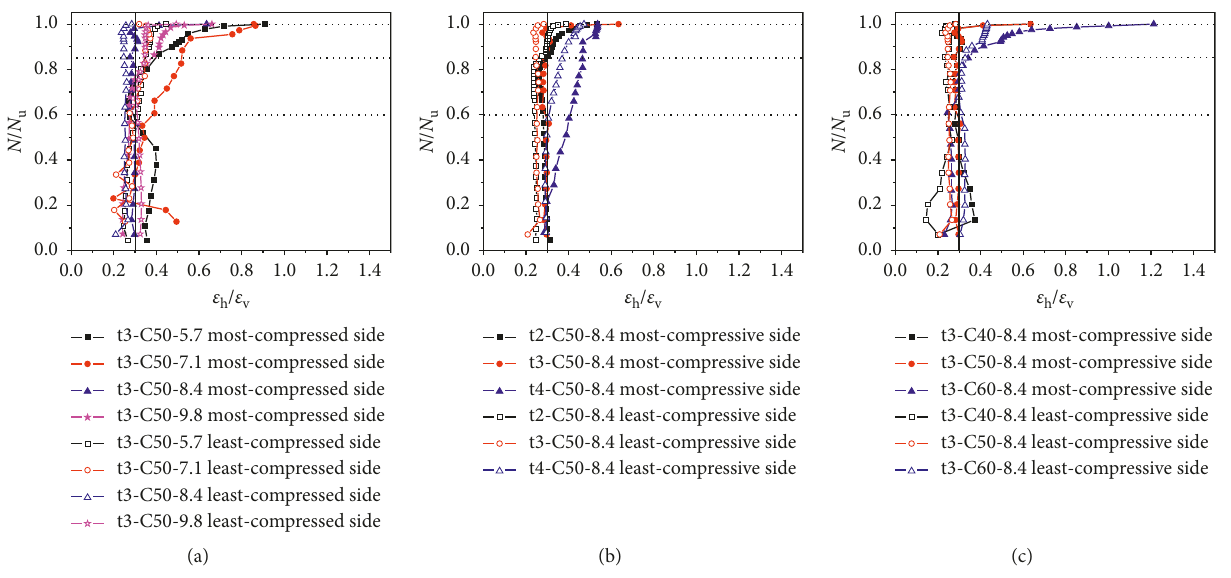
Figure 7: Normalised load-transverse deformation coefficient response. (a) L / D ratio. (b) D / t ratio. (c) SCC